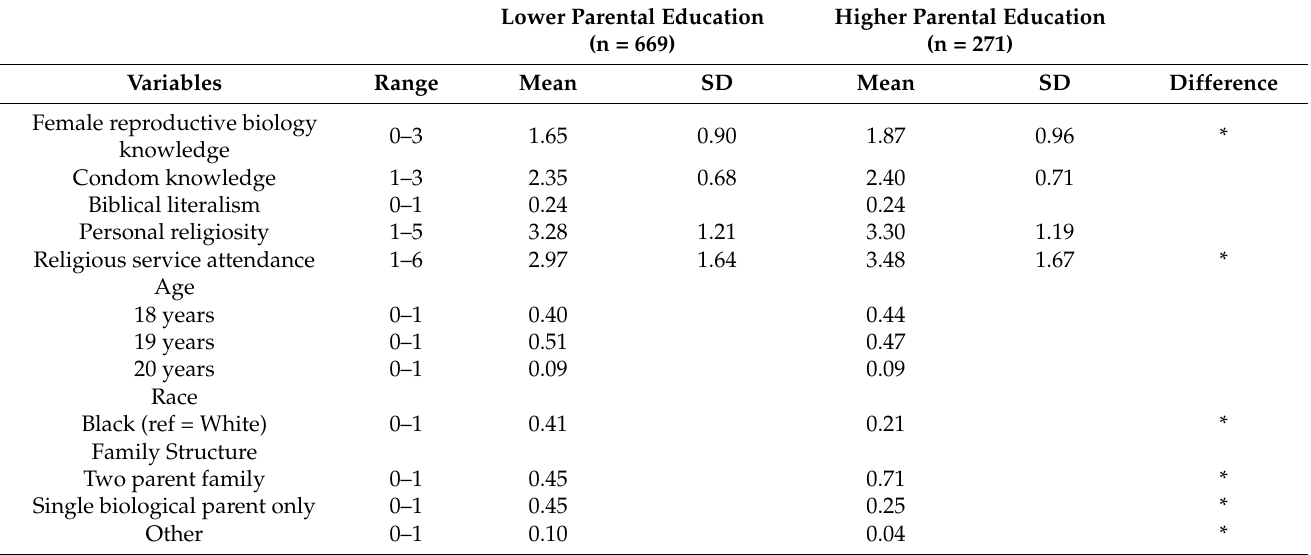
Table 2. Descriptive Statistics by Parent Education Level (RDSL). Lower Parental